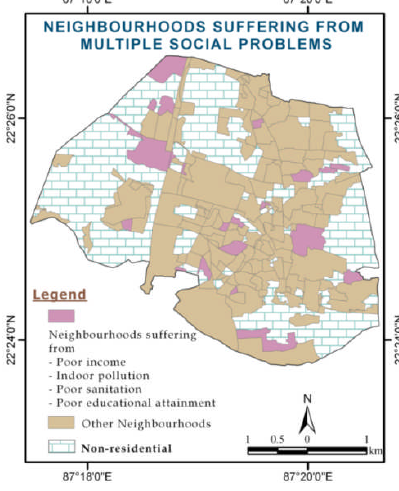
Figure 6. Neighbourhood with multiple suffering social problem have been identified on the basis of calculations carried out by setting upper and lower limits of